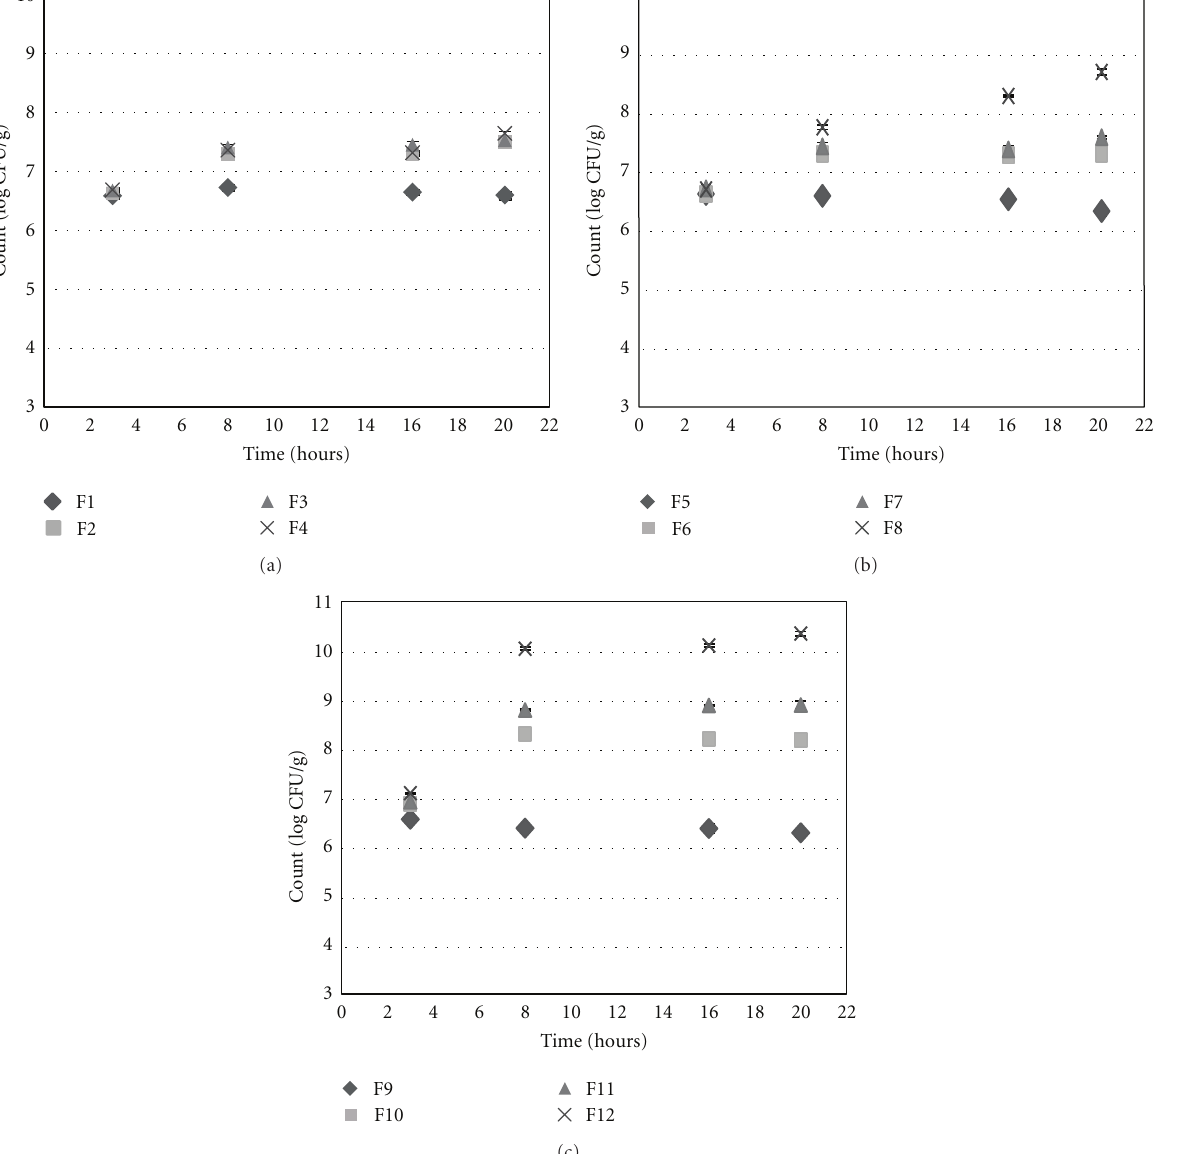
Figure 4: Release of L. acidophilus (CFU/g) in simulated colon pH solution (a) formulations F1–F4 and untreated cells (UT); (b) formulations F5–F8 and UT; (c) formulations F9–F12 and